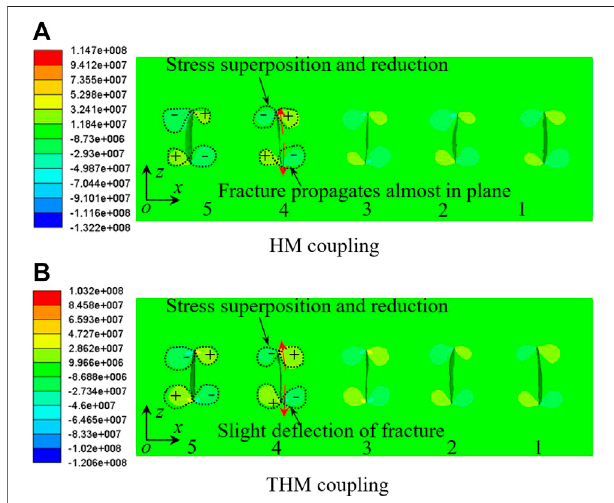
FIGURE6| Disturbance ofshearstress(Pa) insequential fracturing fora cluster spacing of 100 m ( “ + ” represents positive shear stress, and “ − ” represents negative shear